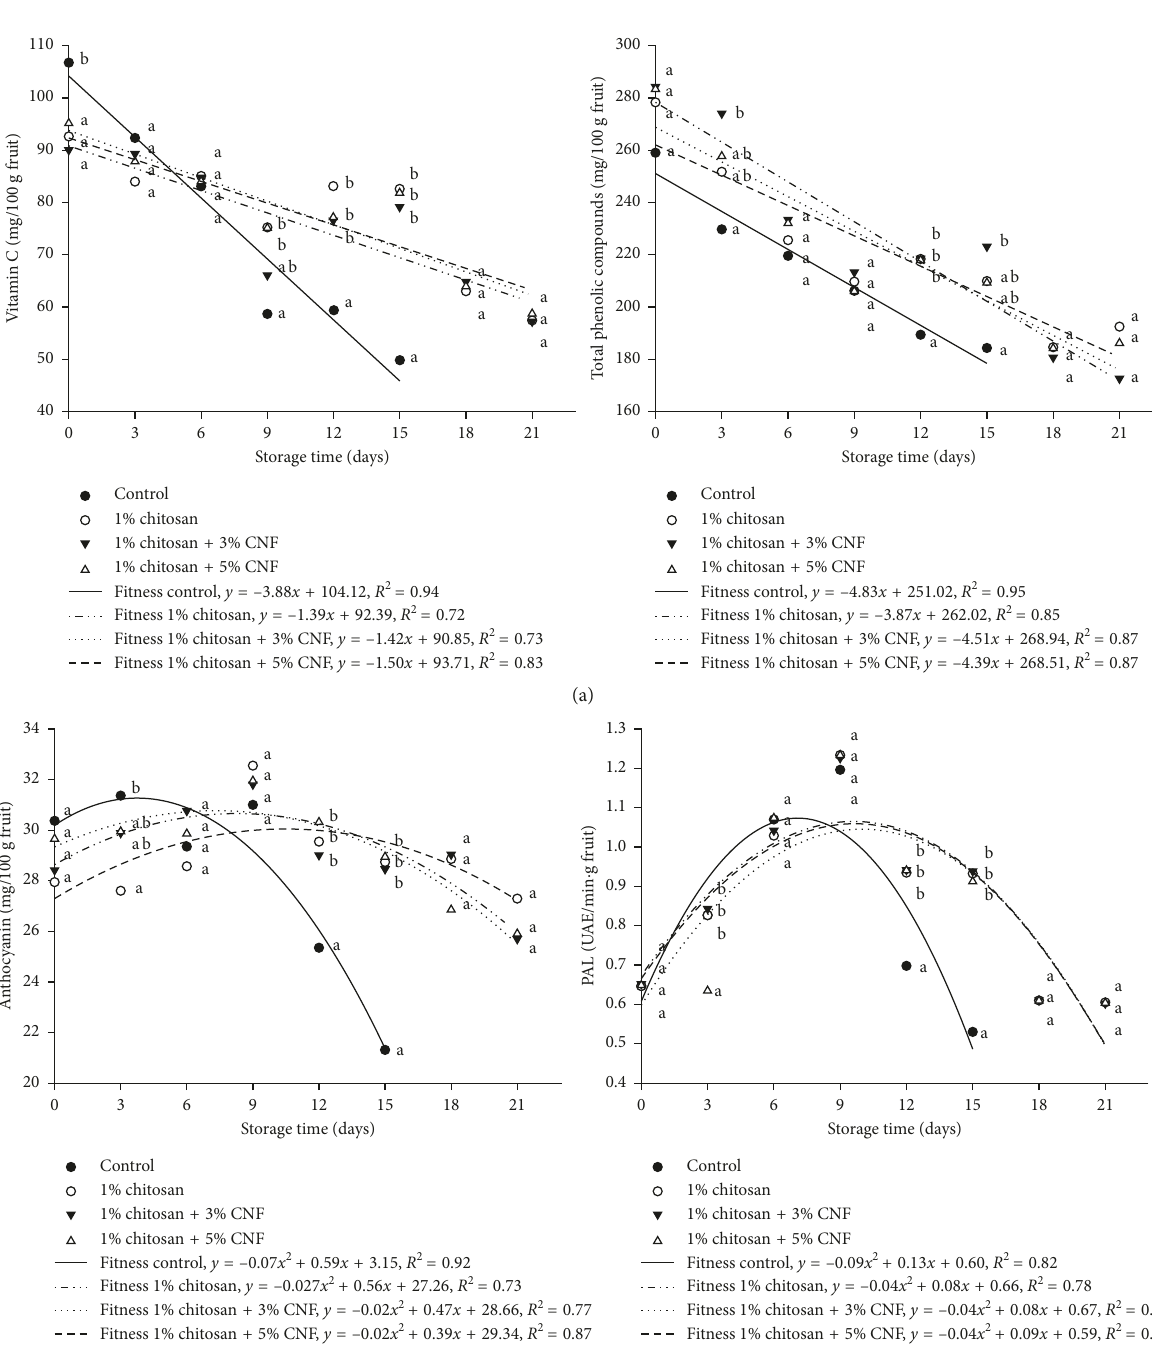
Figure 5: Changes in vitamin C content and phenolic compounds (a) and anthocyanin concentration and PAL activity (b) throughout strawberry storage with and without chitosan film. Same letters in the same storage time denote that averages do not differ by the Tukey test at 5%